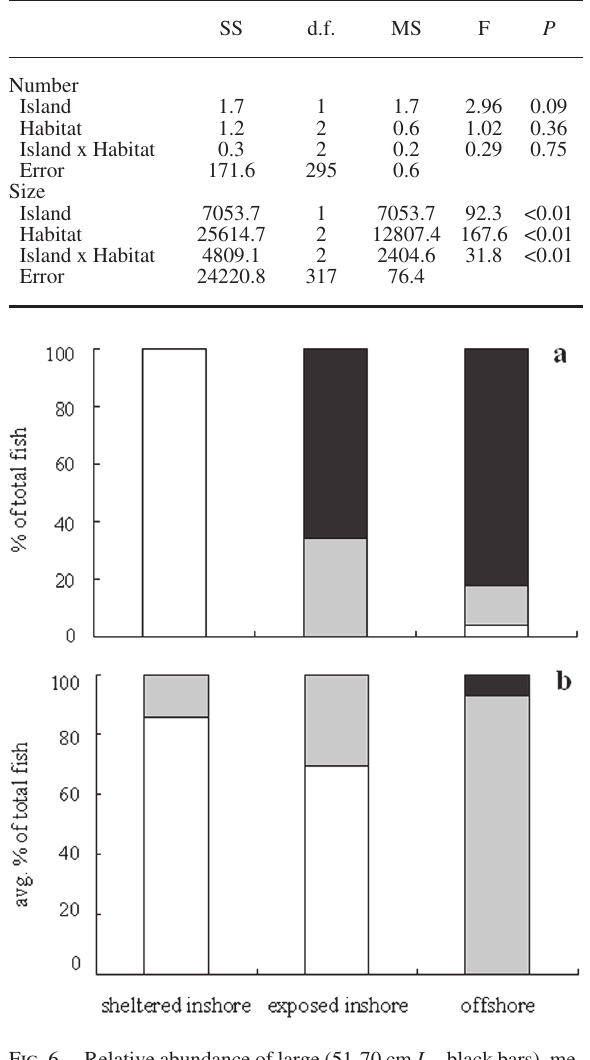
Fig . 6. – relative abundance of large (51-70 cm L , black bars), me- t dium (31-50 cm, grey bars) and small (10-30 cm, white bars) white trevally according to reef habitat type in underwater visual censuses at a) corvo island and b) faial island.